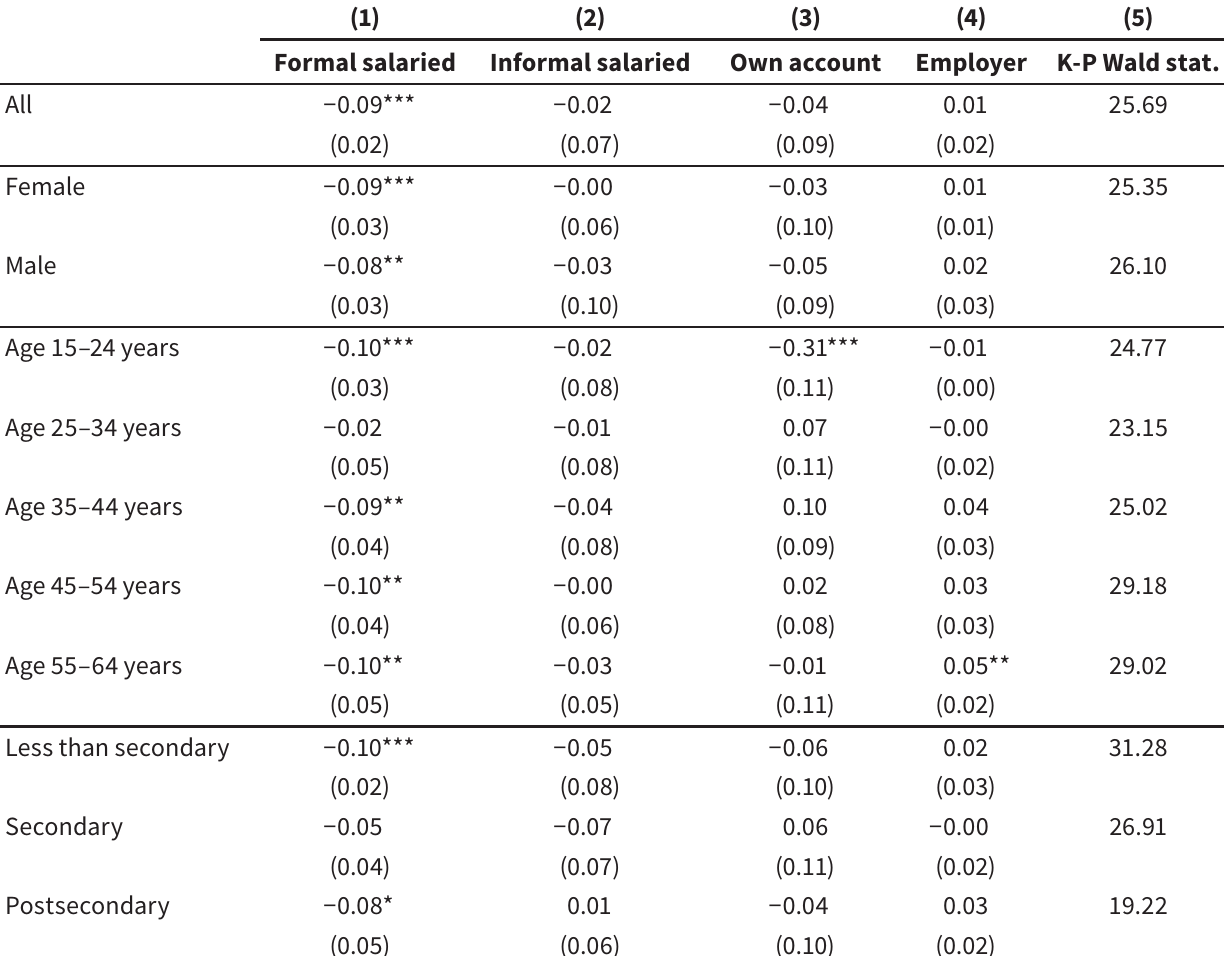
2SLS effects on employment by type of